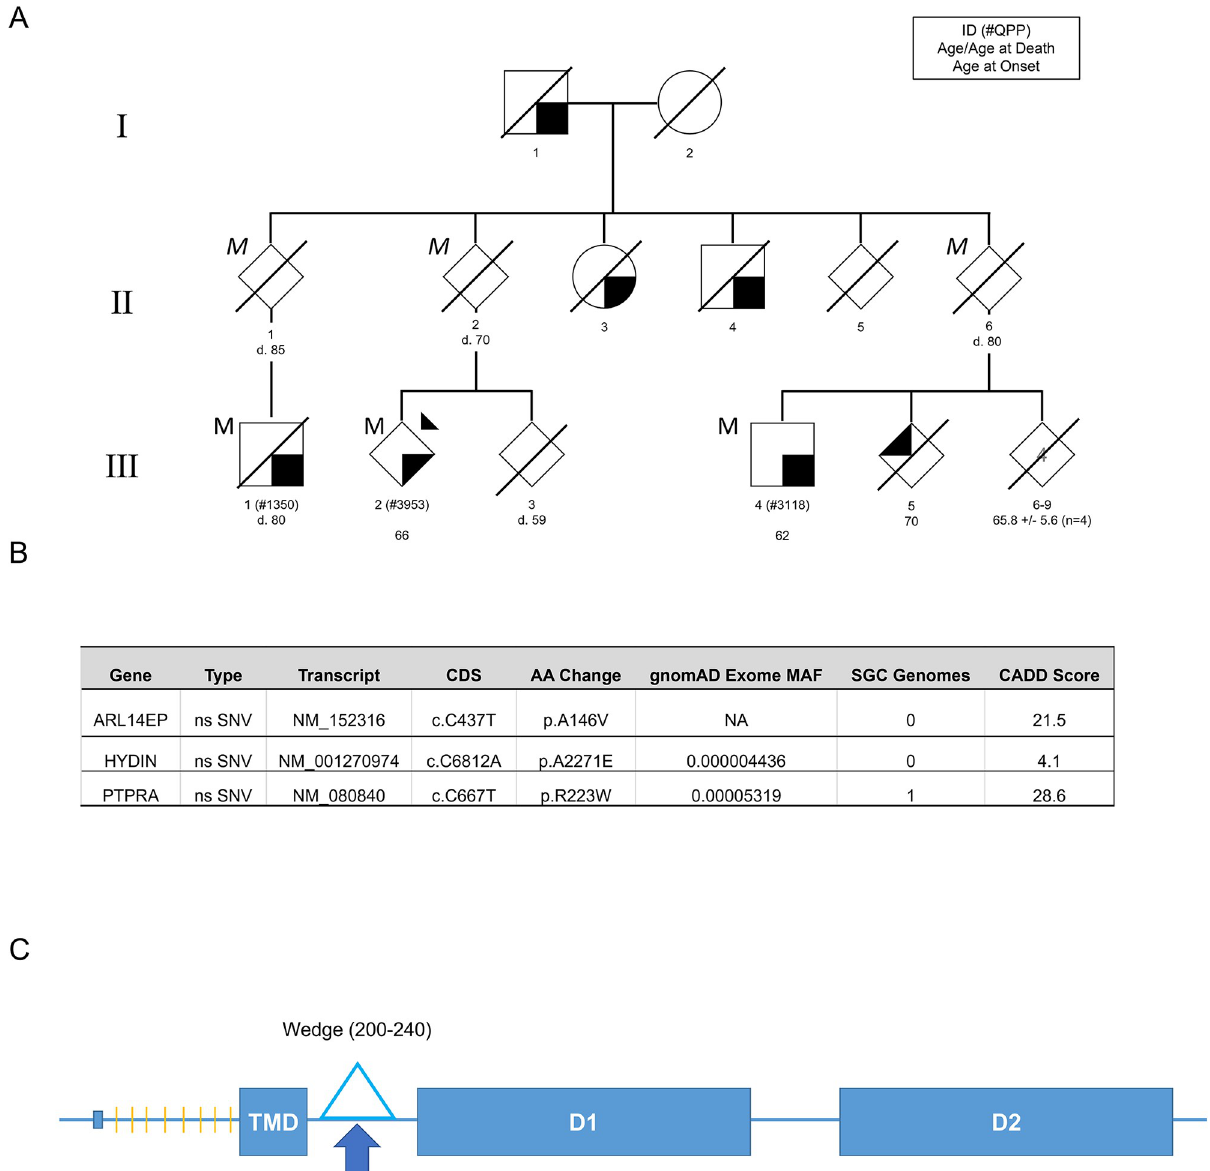
Fig 1. (A) Pedigree of the family carrying the PTPRA mutation. ’M’ indicates confirmed heterozygous carriers of PTPRA mutation, italicised ’ M ’ indicates inferred genotype. Shaded lower right shapes represent PD and upper left represents undiagnosed tremor. Squares represent males, circles represent females and diamonds represent undisclosed gender. Dark triangle represents proband. Diagonal lines represent deceased members. Non- essential pedigree information has been omitted or modified to protect the privacy of the family. Subtext indicates pedigree ID (QPP ID), age / age of death and age at symptom onset. (B) Description of shared rare missense variants identified in three affected cousins. CDS: Coding DNA sequence, gnomAD: Genome Aggregation Database, SGC: Sydney Genomics Collaborative, CADD: Combined Annotation Dependent Depletion. (C) Schematic diagram of the RPTP α protein. Orange lines represent N-linked glycosylation sites. TMD = transmembrane domain. Arrow indicates the R223W mutation. D1 and D2 are the phosphatase